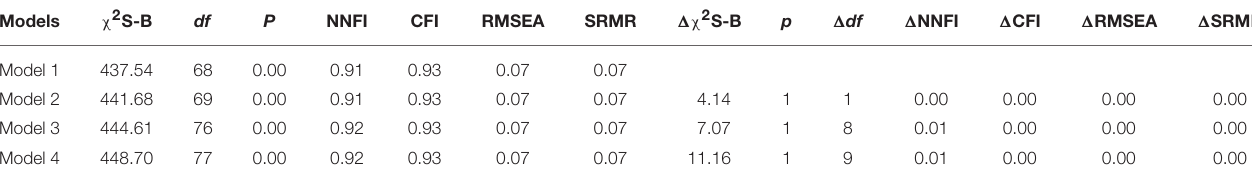
TABLE 2 | ERQ Multi-group analysis in boys and girls: metric and residual invariance. Models